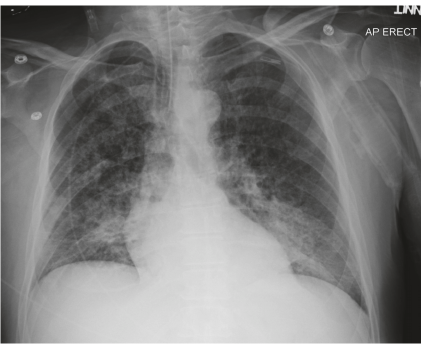
Figure 1: Chest X-ray showing features of pulmonary edema.